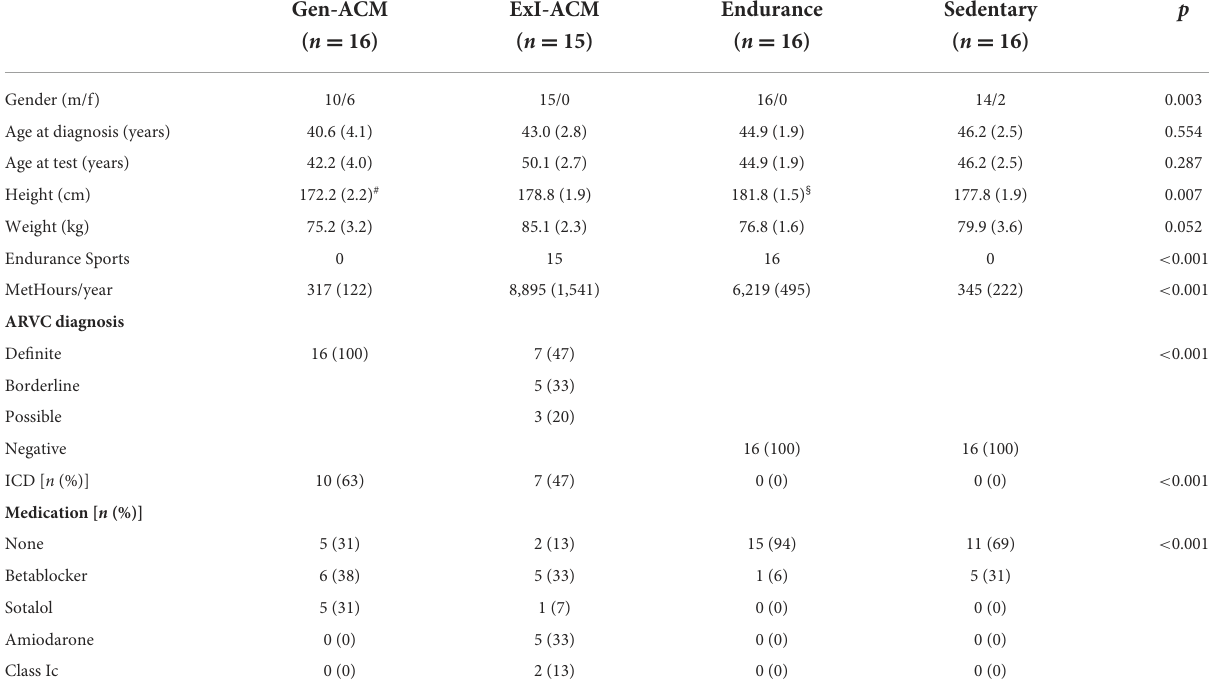
TABLE 1 Baseline